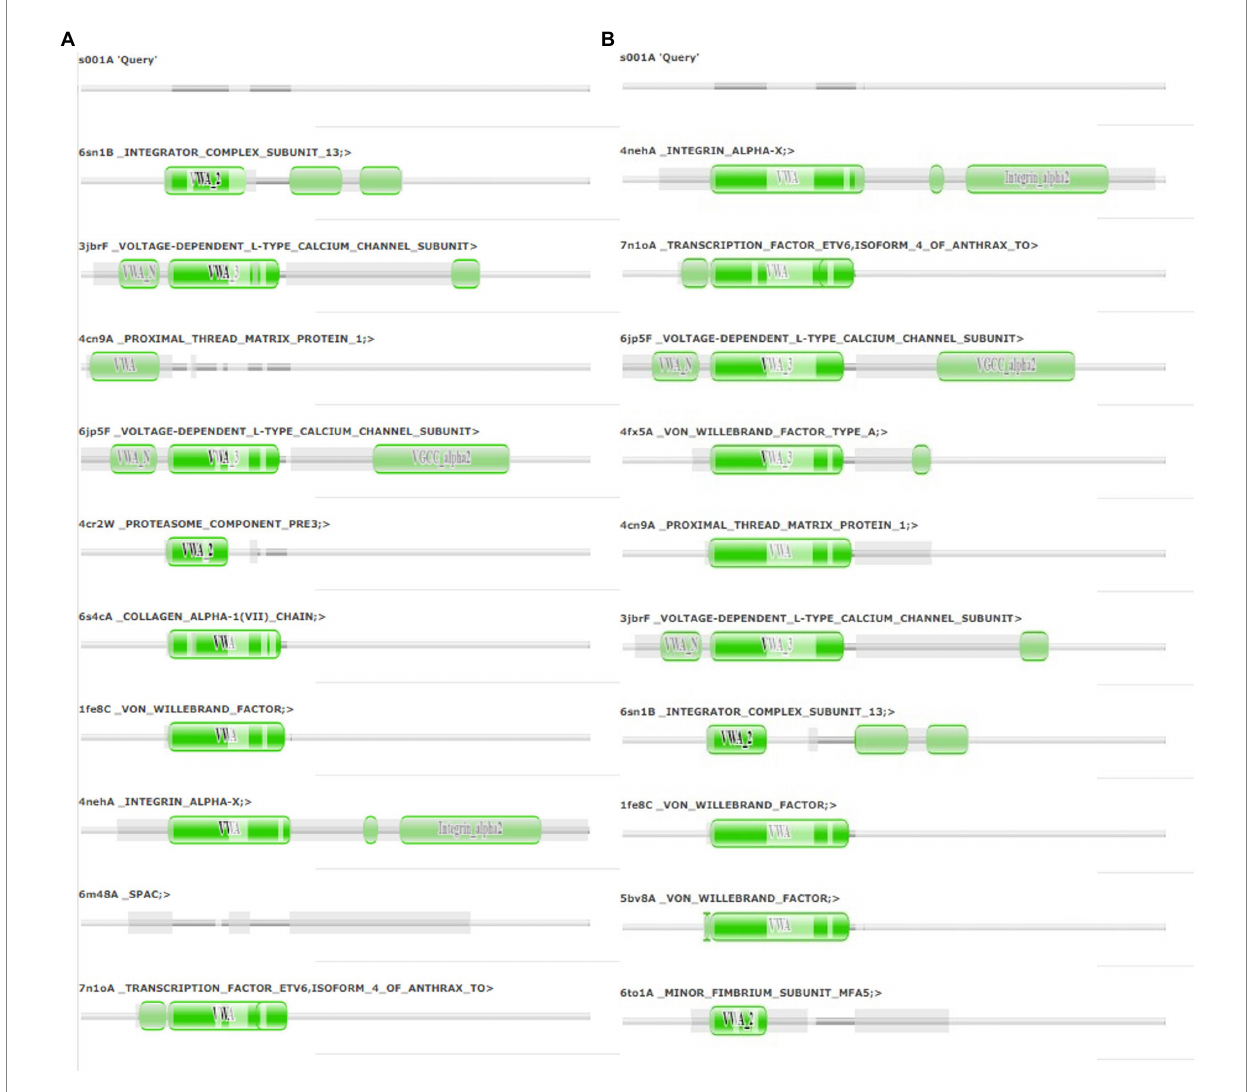
FIGURE 11 Pfam alignment from DALI server: (A) Alignment of ASP_NL4-3 with top 10 ranking matches from DALI. (B) Alignment of ASP_Indie-C1 with top 10 ranking matches from DALI. Dark green shading marks structural equivalence with the query structure, light green shading means the domain is located in an unaligned region. Structurally equivalent domain families are shown as vertically aligned dark green